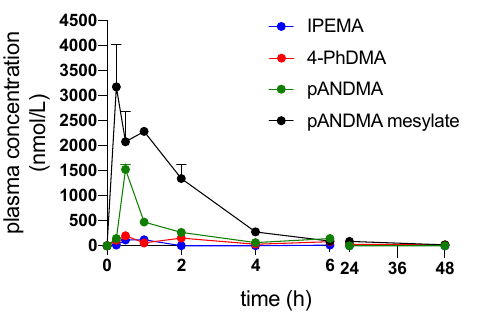
Figure 6. Plasma concentration versus time curves obtained after administration of the selected compounds IPEMA , 4-PhDMA , pANDMA , and pANDMA mesylate suspended or dissolved in water to c57BL/6 male mice.